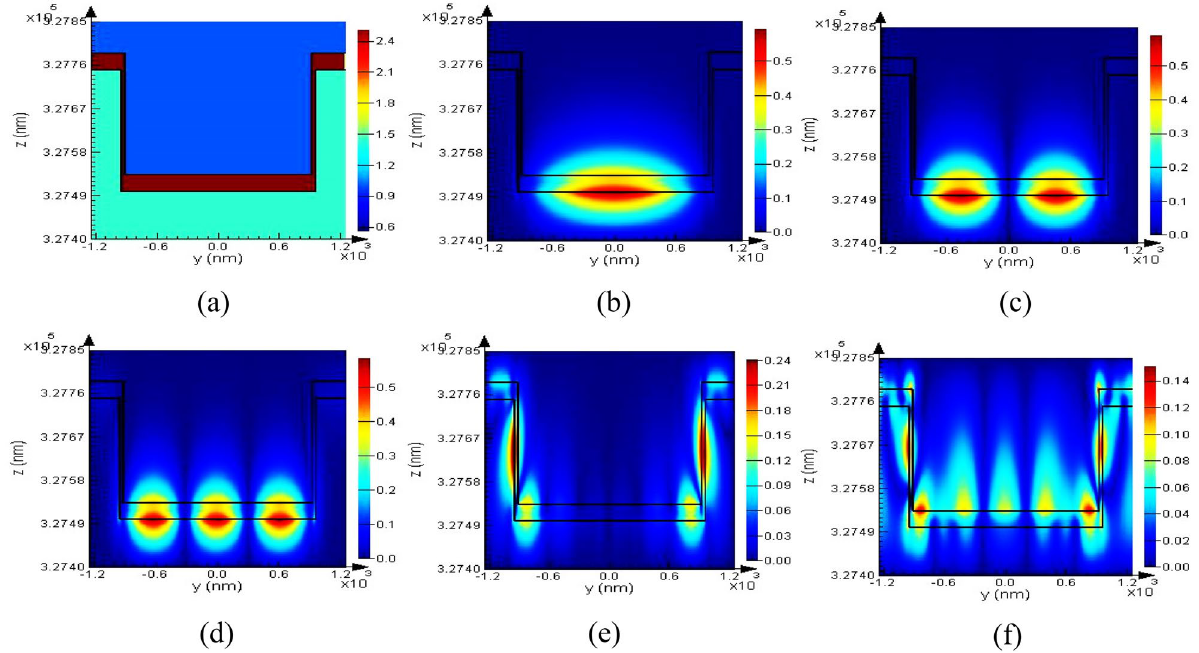
Figure 7. ( a ) The refractive index profile of each unit cells of the simulated structure. ( b–d ) Electric field distribution of the first three modes at λ res = 560 nm, respectively, and ( e,f ) the other orders of the electric field distribution which indicate electric field localization at the sharp edges of the unit